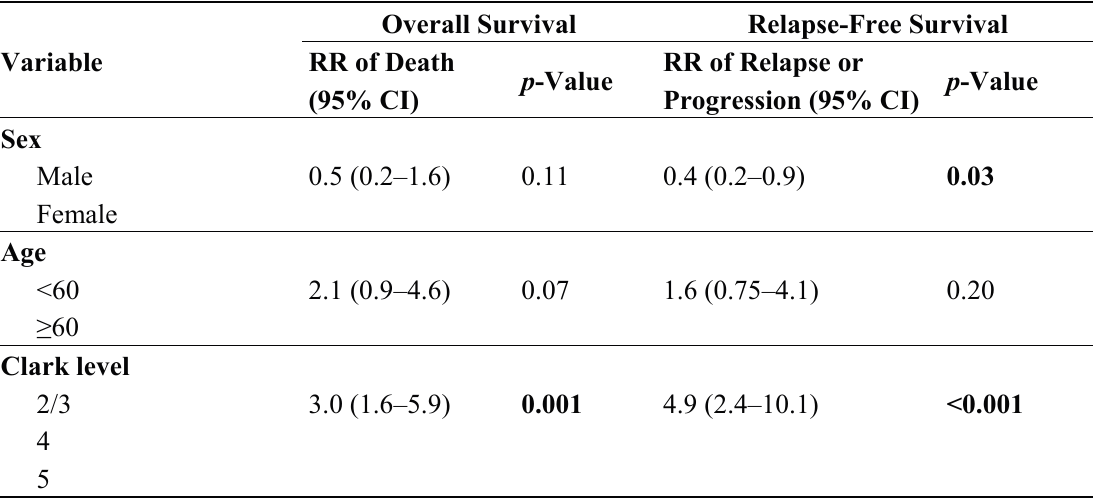
(Table 2). After exclusion of a subgroup of 16 patients, who received an adjuvant interferon alpha therapy, TNFRSF10D DNA-methylation still remained the highest significant prognostic parameter in the multivariate analysis for overall ( p = 0.004) and relapse-free survival ( p = 0.001). Table 2. Multivariate survival analysis of 68 melanoma patients. RR, relative-risk. Significant p -values in